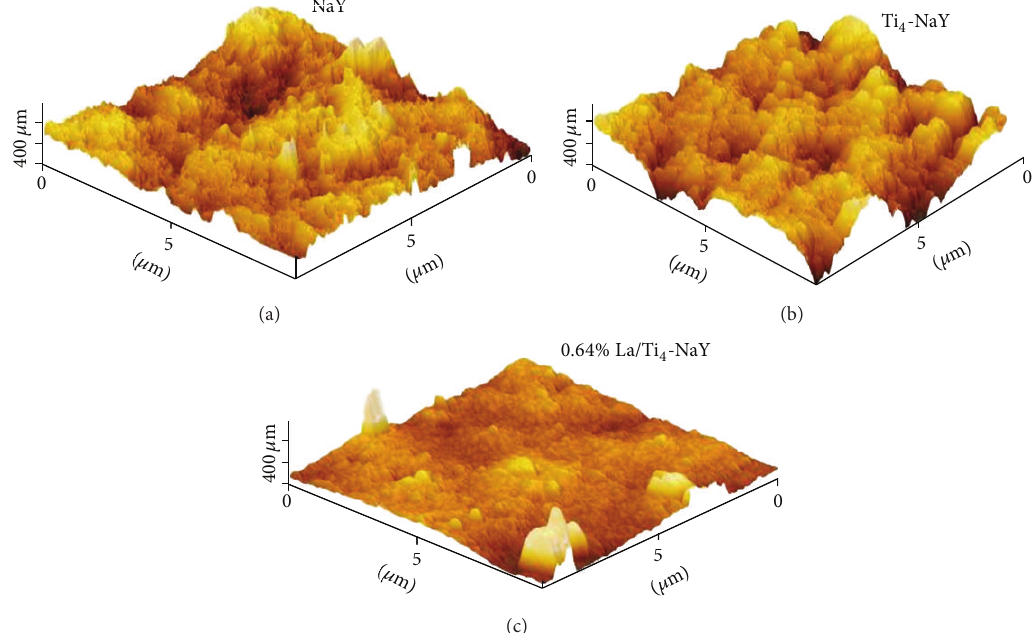
Figure 6: AFM 3-dimensional images for different samples.